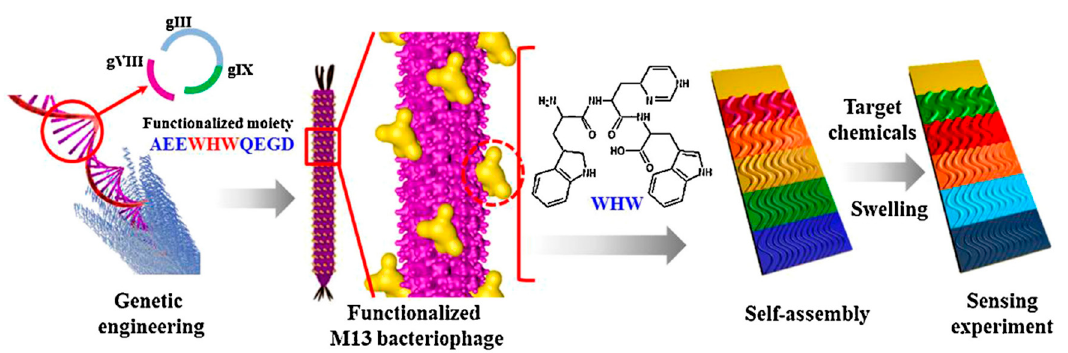
Figure 9. Scheme of phage-based colorimetric sensor preparation. M13 bacteriophages are engineered to display WHW ( π aromatic interacting motif) on their pVIII major coat proteins. Subsequently, phages are pulled on the carrier to form a self-assembled structure [94]. Reprinted from [94], Copyright 2017, with permission from Elsevier.